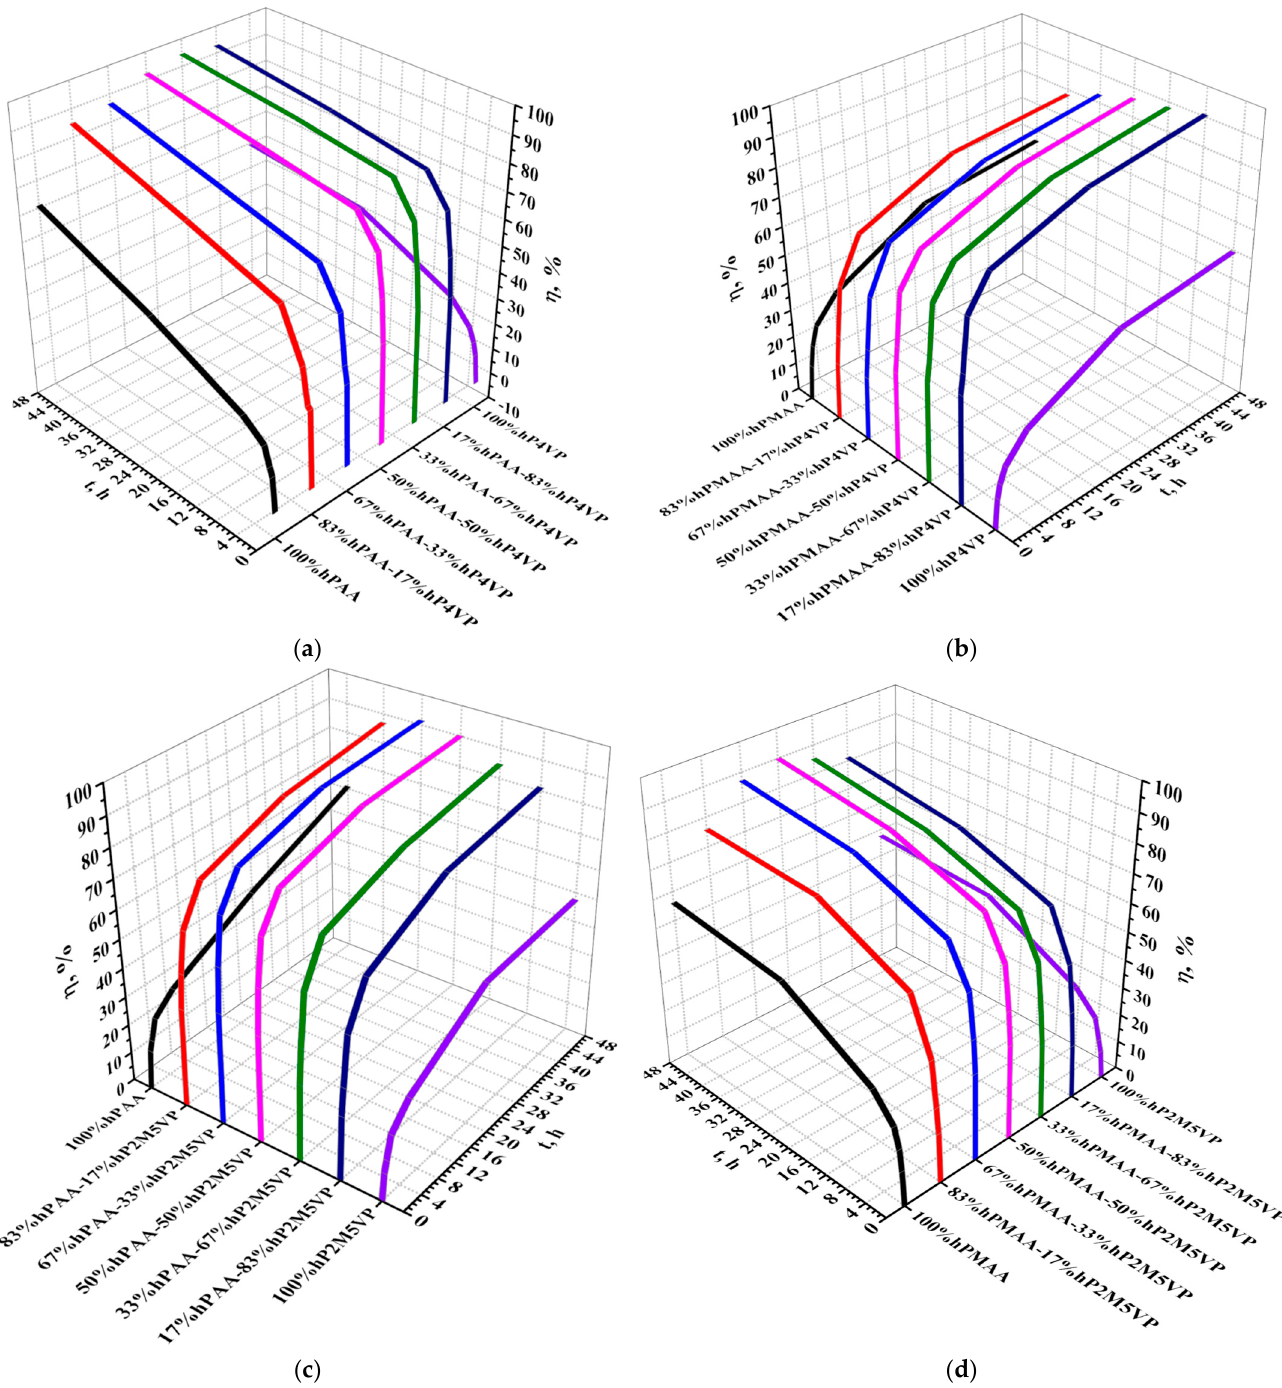
Figure 6. Extraction degree of lanthanum of the interpolymer systems hPAA-hP4VP ( a ),